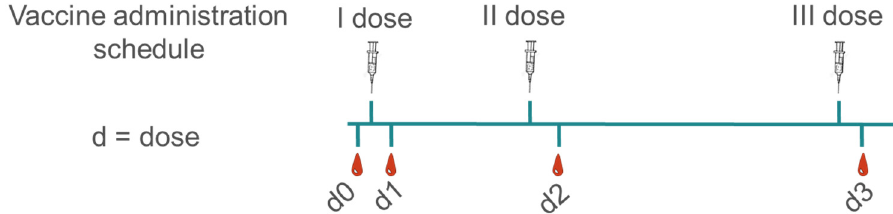
Figure 1. Vaccination schedule and blood sample collection: serum samples were collected before vaccination (d0), and seven days after each dose of vaccine (d1, d2 and d3). Vaccine schedule was I and II dose 21 days apart, and III dose 6 months following the II dose. All volunteers received BioNTech/Pfizer as t I and II dose, whereas for the III dose either BioNTech/Pfizer or a half-dose of Moderna were administered.